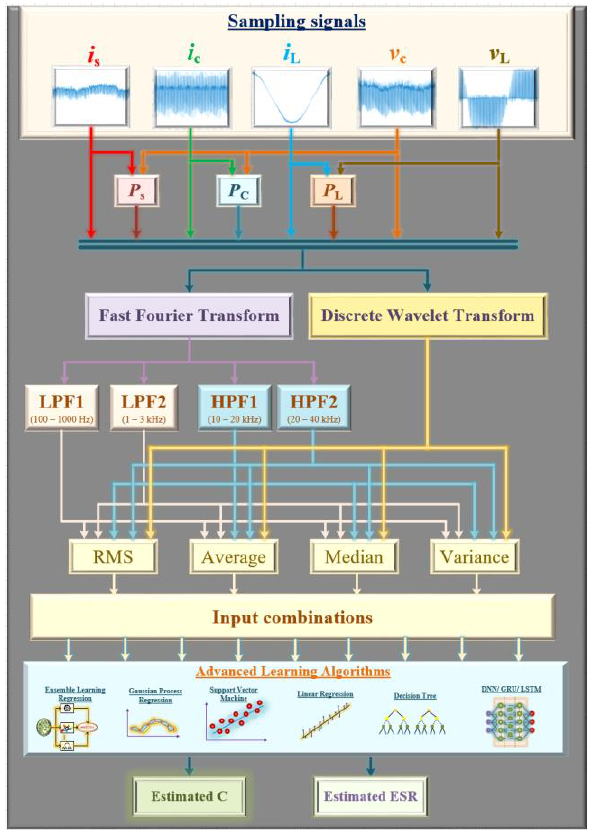
Figure 8. Capacitor estimation scheme. Table 5. Frequency range of the filters.